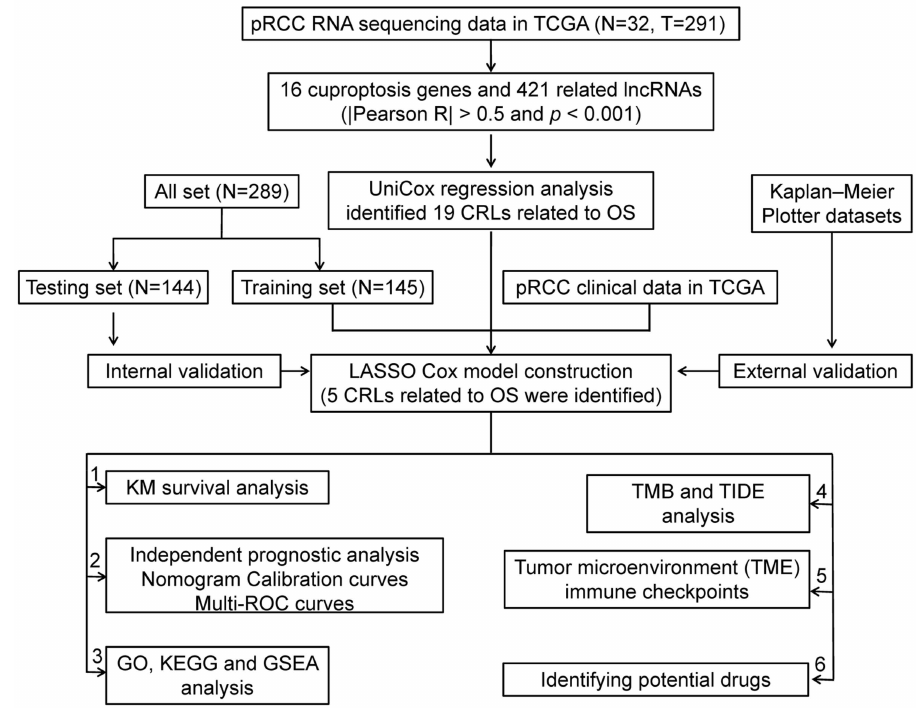
Figure 1. Flow chart of this study.